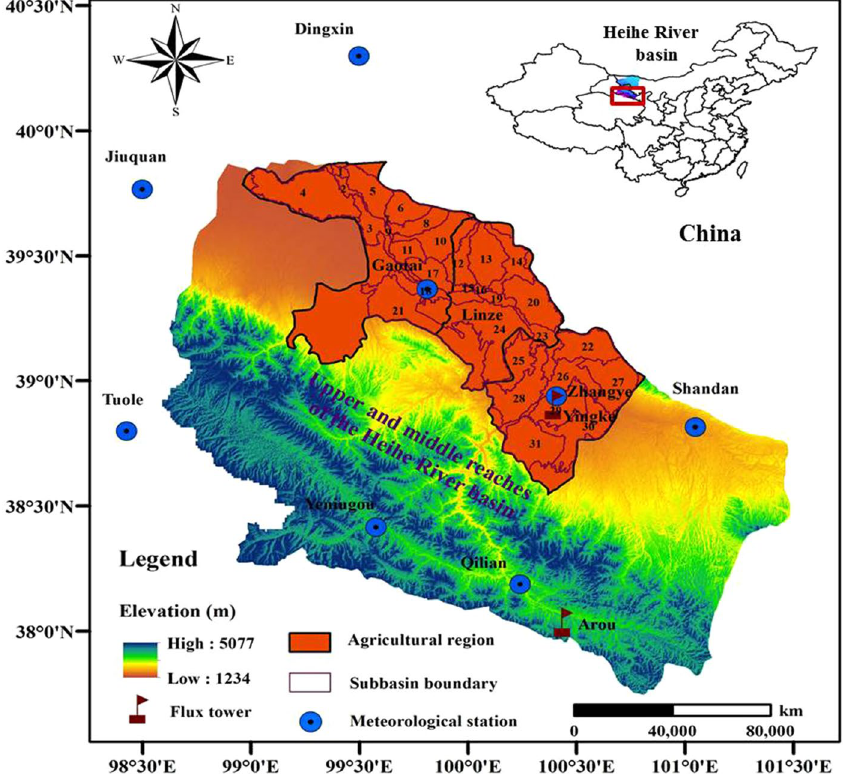
Figure 1. The area of study, showing the agricultural region in the Heihe River basin. The DEM of 30 m spatial resolution obtained from the Date Management Center of the Heihe Research Program (http://heihedata.org/). This figure was created using ArcGIS10.0 software provided by the Environmental Systems Research Institute